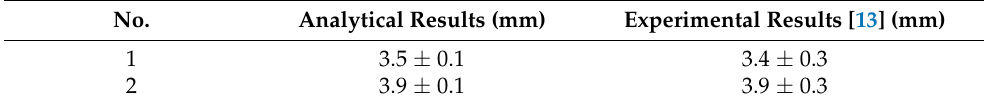
Table 7. Comparison of results for the waist width d W